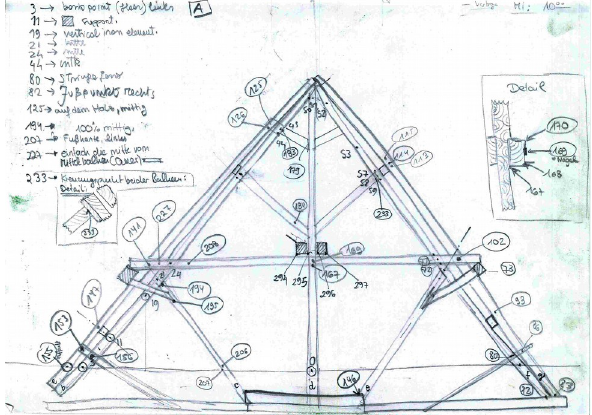
Figure 11. Hand-measured sketches the pagoda with observation on the connection’s methods and fasteners.